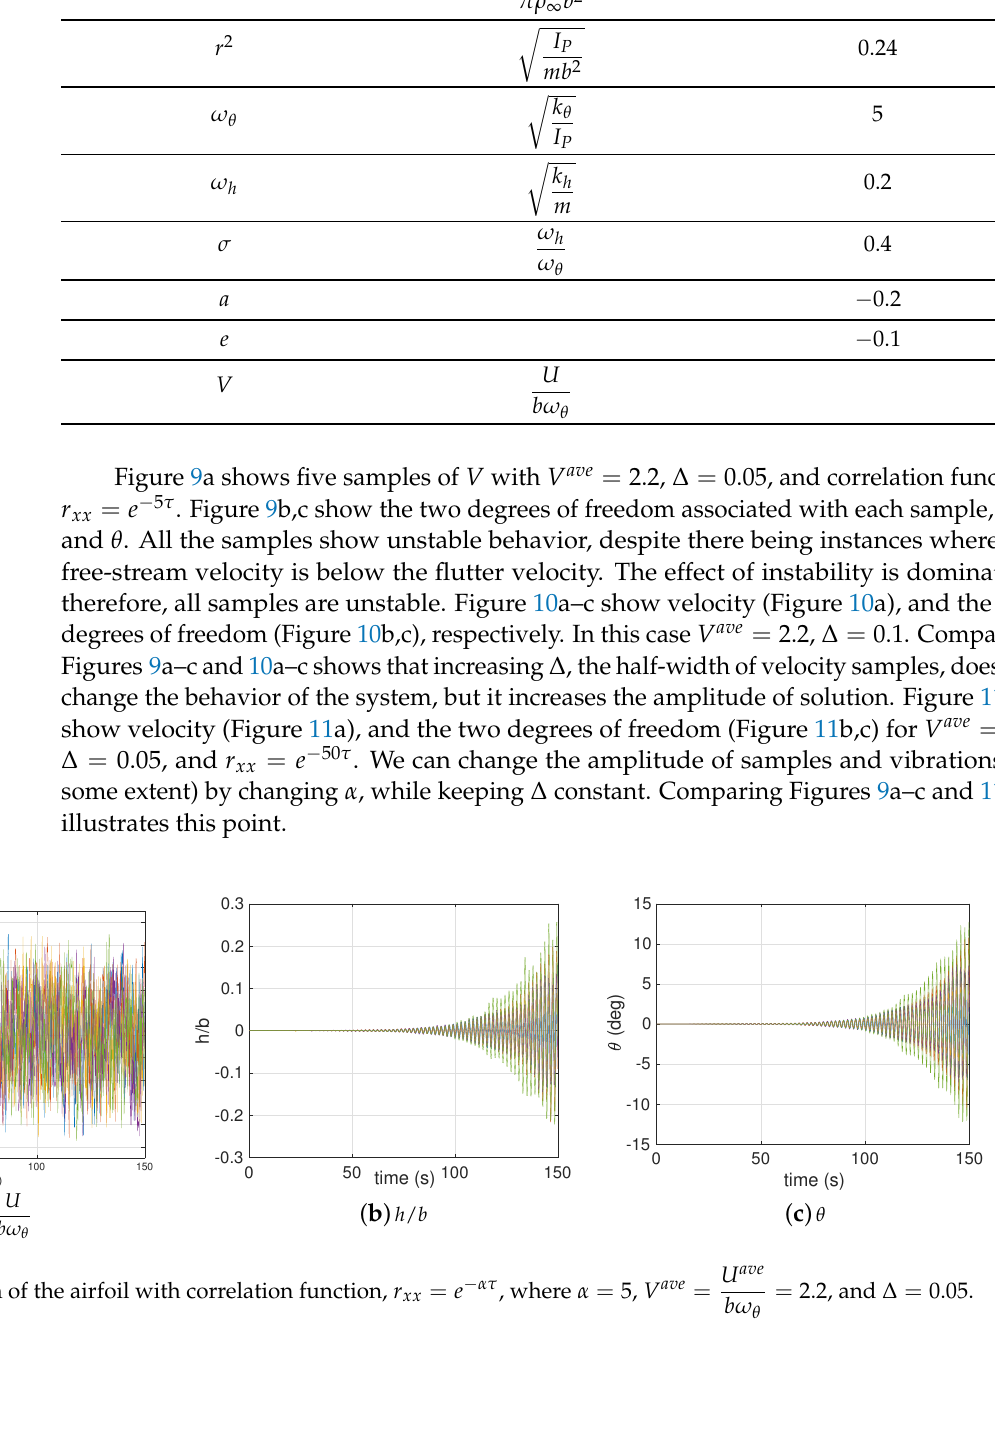
Figure 9. Oscillation of the airfoil with correlation function, r xx = e − ατ , where α = 5, V ave =